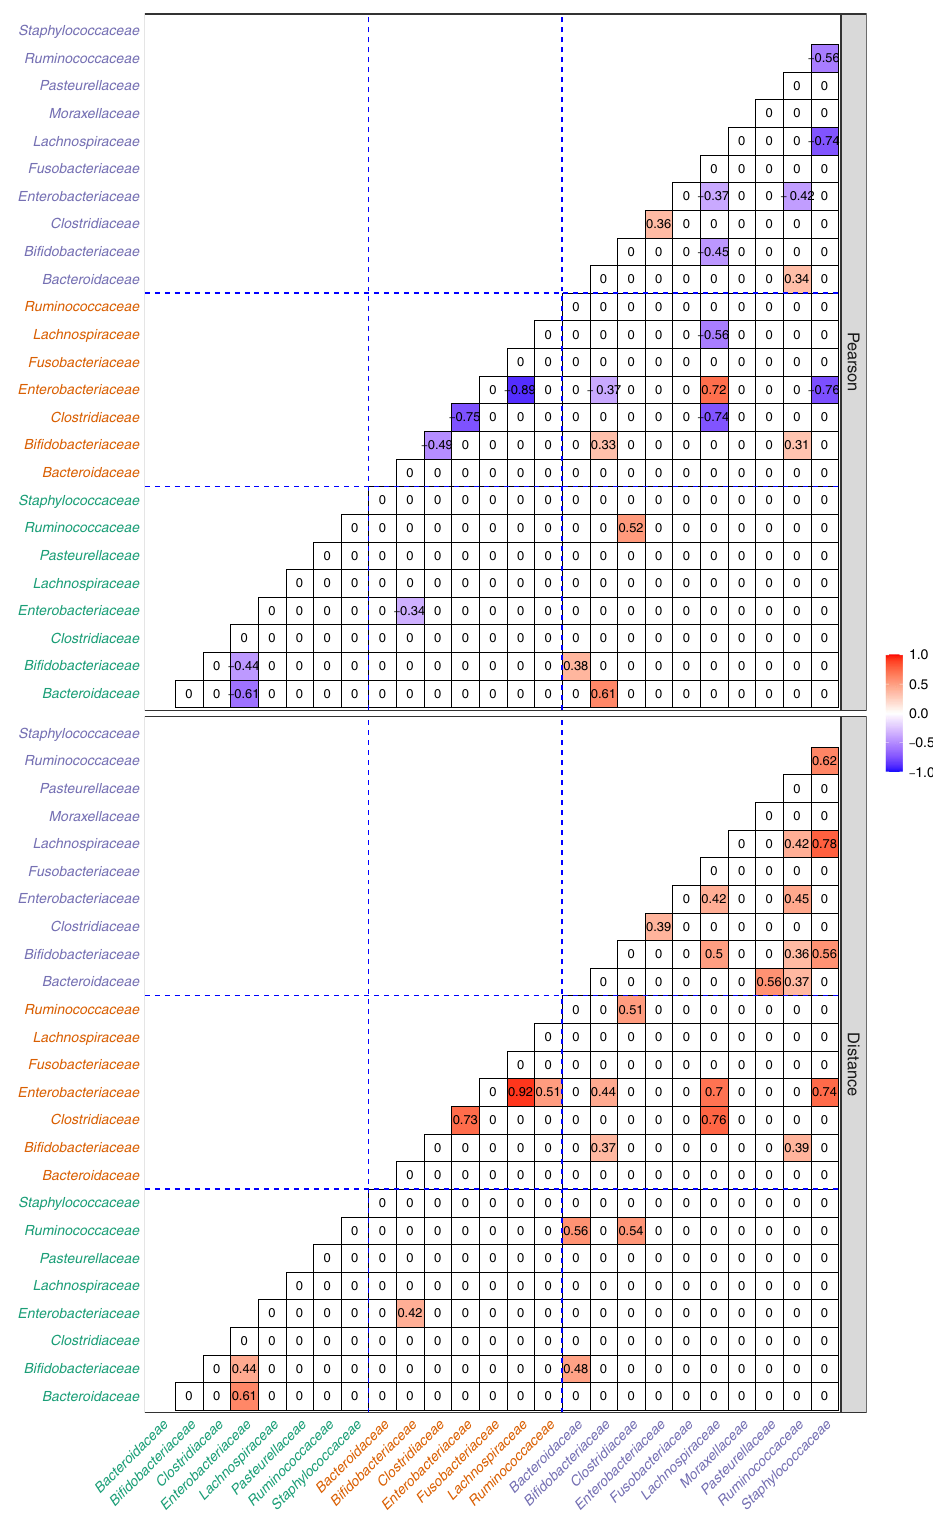
Fig.7|TemporalpatternsofcorrelationsforNorwegianinfantgutmicrobiome data among families. The correlation measures (Pearson and Distance) are represented by rows. Families from days 30, 120, and 365 are colored in green, brown, and purple on the x and y axes, respectively. Blue dashed lines are used to